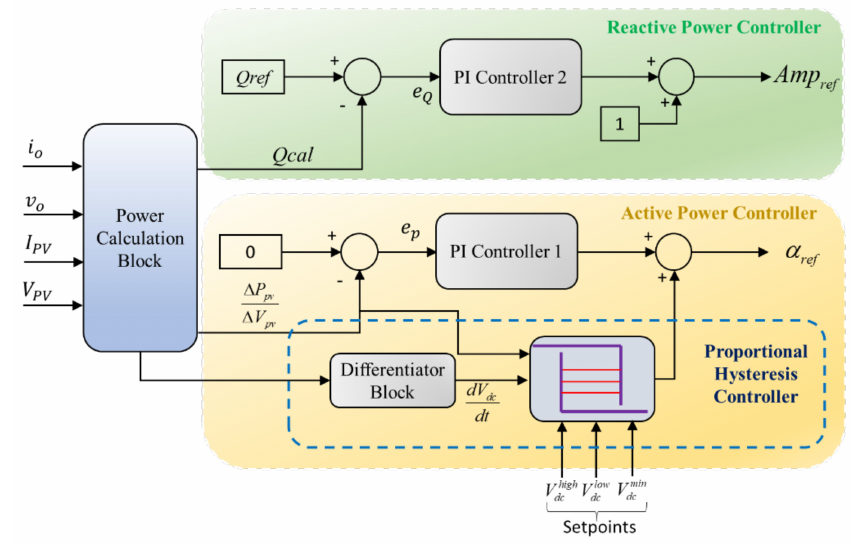
Figure 3. Proposed control block diagram of the PV